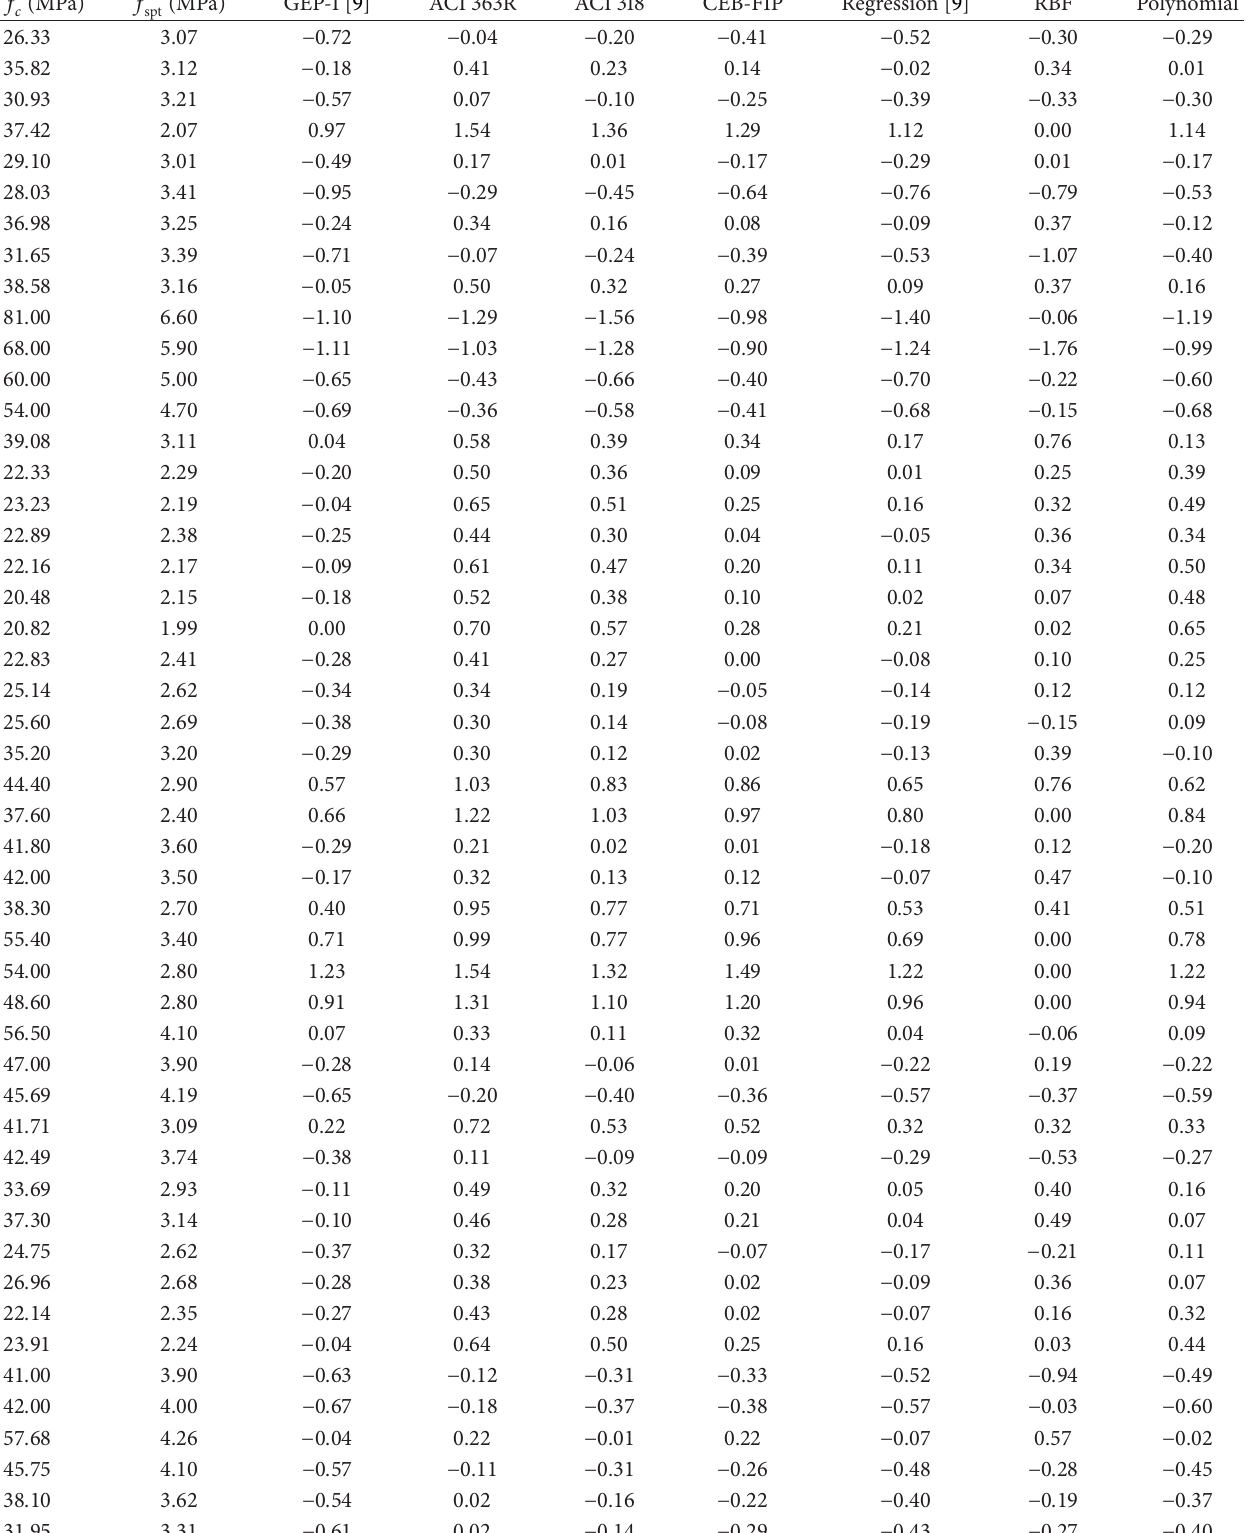
Table 2: Comparison of experimental results to training results of RBF Polynomial of SVM-I, and other models. 𝑓 𝑐